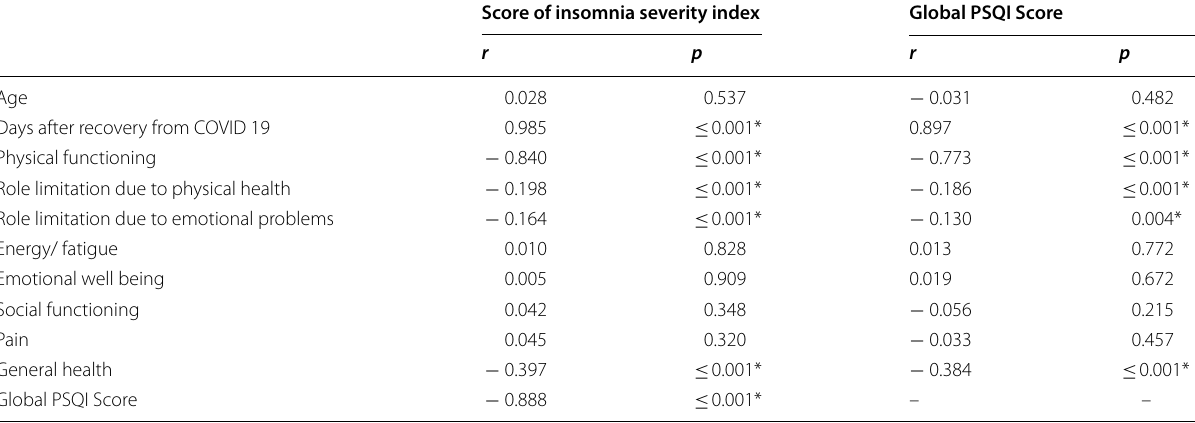
*Statistically significant results